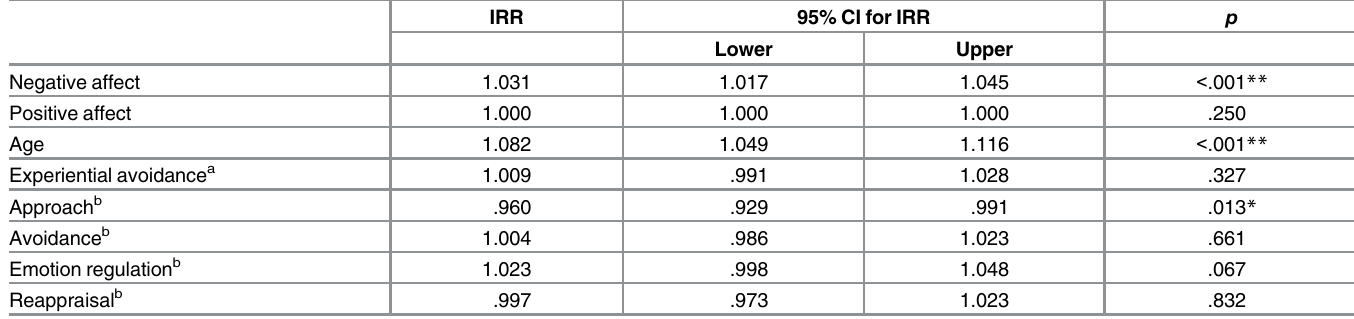
Table 7. Multivariate negative binomial regression exploring whether functional coping dynamics and experiential avoidance predict self-harm lifetime frequency, when adjusting for age and affect ( n =